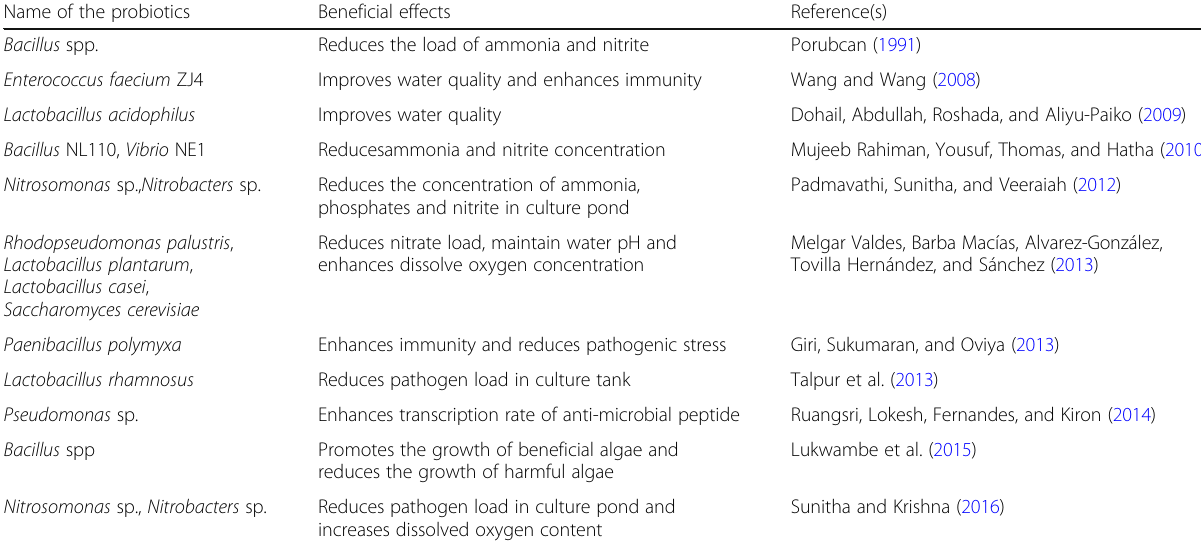
Table 2 Water probiotics and their role in maintaining water quality Name of the probiotics